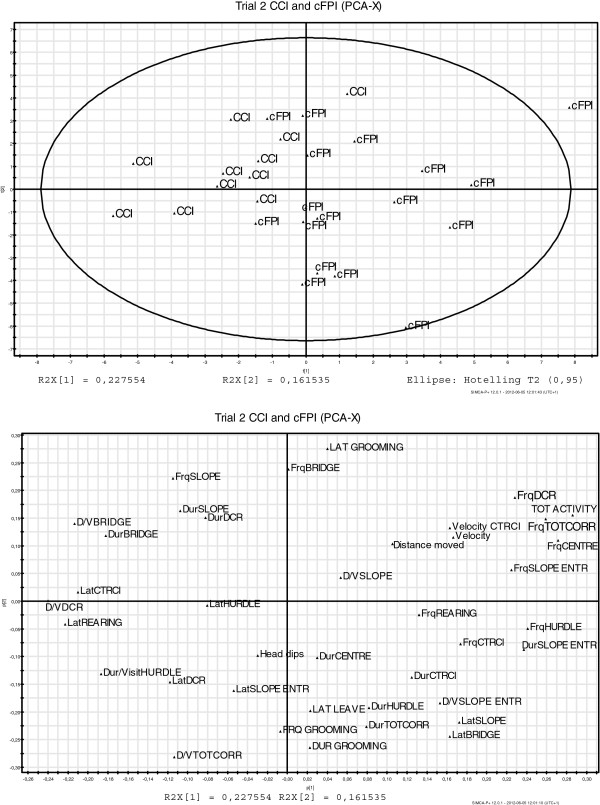
The principal component analysis (PCA) from the second MCSF test, 7 (CCI-injured animals, [28]) or 9 (cFPI animals) days post-injury. (A) PCA score plot showing the locations of the CCI and cFPI groups, indicating different behavioral patterns in the two groups; (B) PCA loading plot illustrating the MCSF variables that are included in the analysis. Variables located further away from the origin are most important for the model. CCI: Controlled cortical impact, n = 11 (from [28]); cFPI: Central fluid percussion injury, n = 16; CTRCI: Central circle; Dur: Duration; D/V: Duration per visit; Frq: Frequency; Lat: Latency; SLOPE E: Slope entrance; TOT ACTIVITY: Total activity in arena; TOTCORR: Total corridor entries.